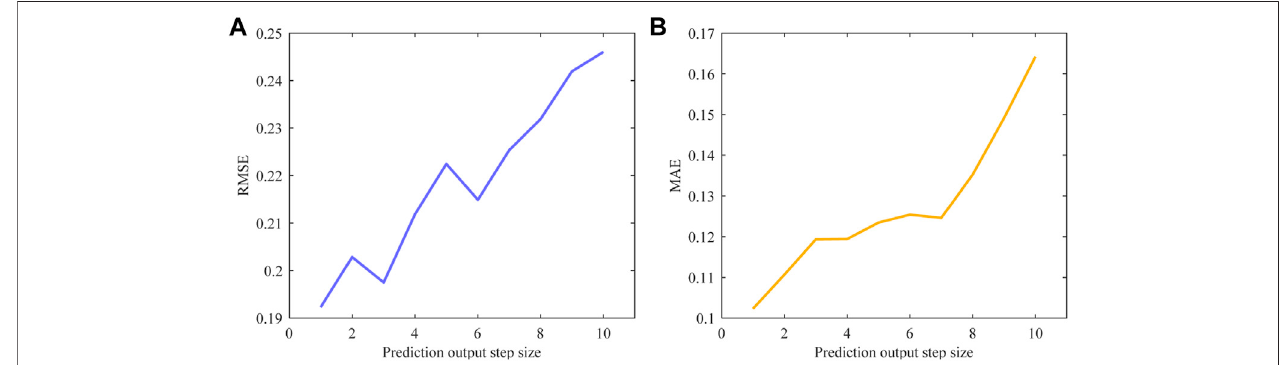
FIGURE 9 | (A) RMSE values for different prediction step sizes; (B) MAE values for different prediction step